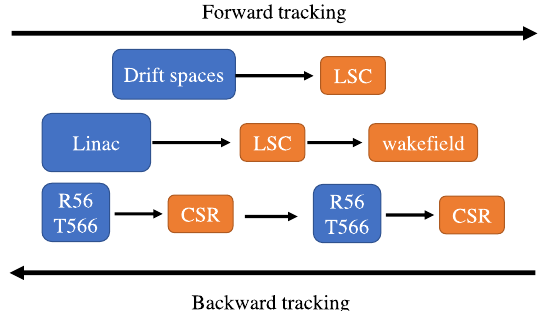
FIG. 21. Treatment of collective effects as energy kicks down- stream of beam line elements. In forward (respectively backward) tracking, transformations of beam line elements (respectively energy kicks) were applied, followed by energy kicks (respec- tively beam line